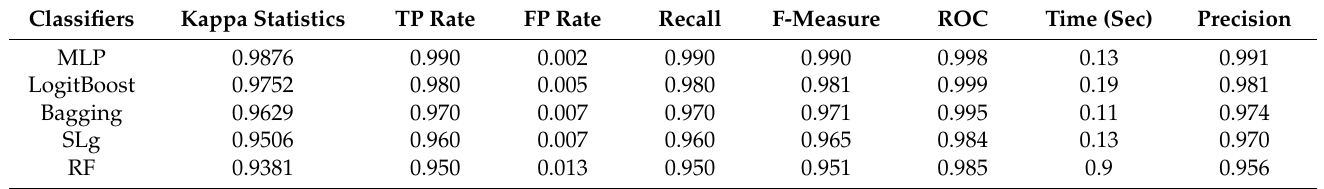
Table 4. Classification of medicinal plant leaves using five ML classifiers with ROO’s size of (280 × 280).